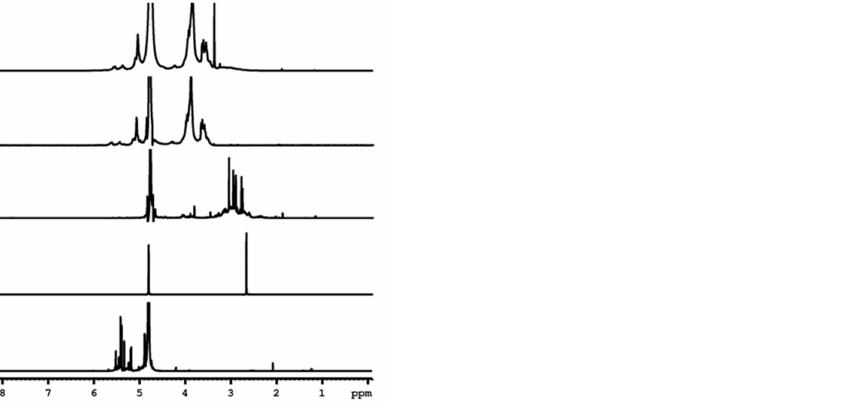
Figure 1. 1 H-NMR spectra (D 2 O, 400 MHz) between 9 and 0 ppm chemical shift, for glyoxal ( 1 ); ED ( 2 ); Schiff base, the intermediate compound obtained during interactions of glyoxal and ED in 1:2 molar ratio after 30 min of reaction ( 3 ); MCT- β –CD ( 4 ); D-CD (obtained during interactions of Schiff base and MCT- β -CD) ( 5